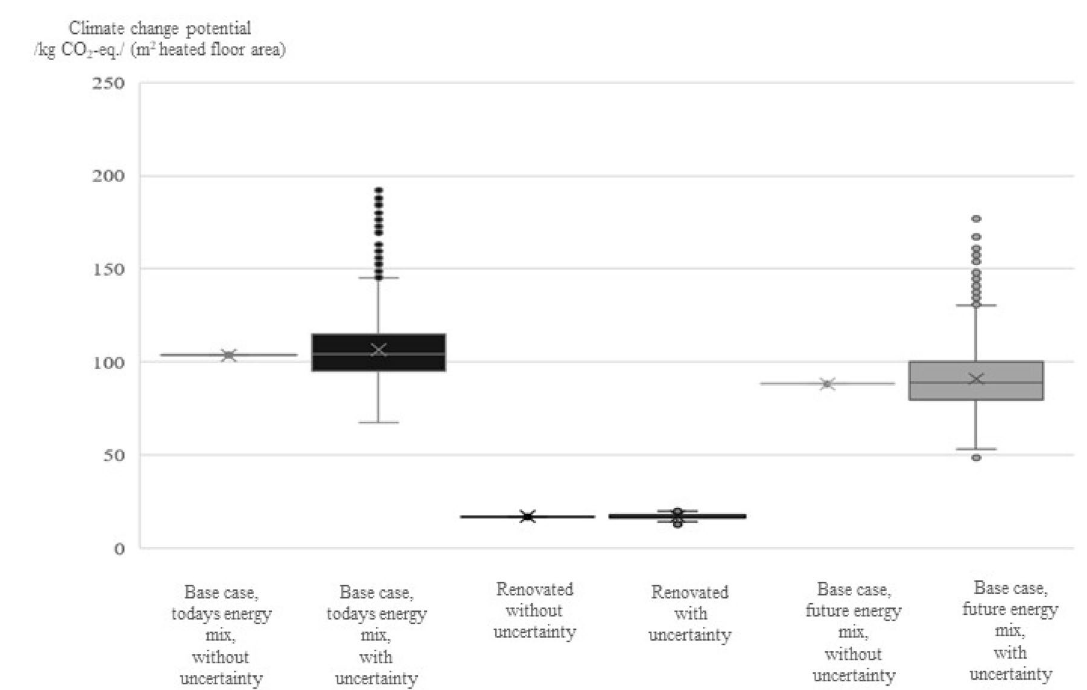
tion system. Results are shown with and without consideration to the uncertainties in the input data and with two different scenarios for the energy mix